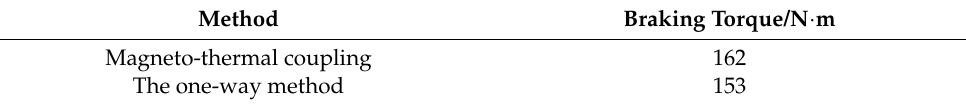
Figure 12. Armature force simulation at different method. The static braking torque of the brake is linearly related to the force on the armature, and the braking torque of the brake can be calculated using Formula (10). The braking torque calculation with a different evaluation method is shown in Table 2. Table 2. The brake torque calculation with different methods.